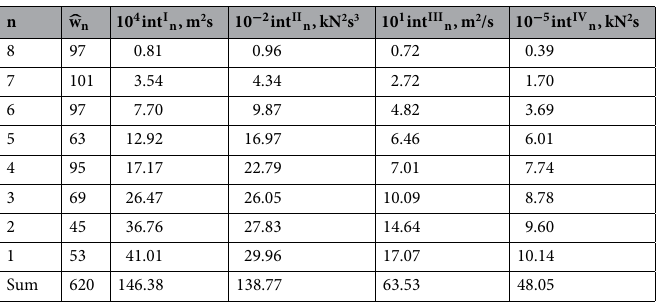
˙ δ ( t ) minimization is prioritized: Q 1 = I , Q 2 = I , Q 3 = 10